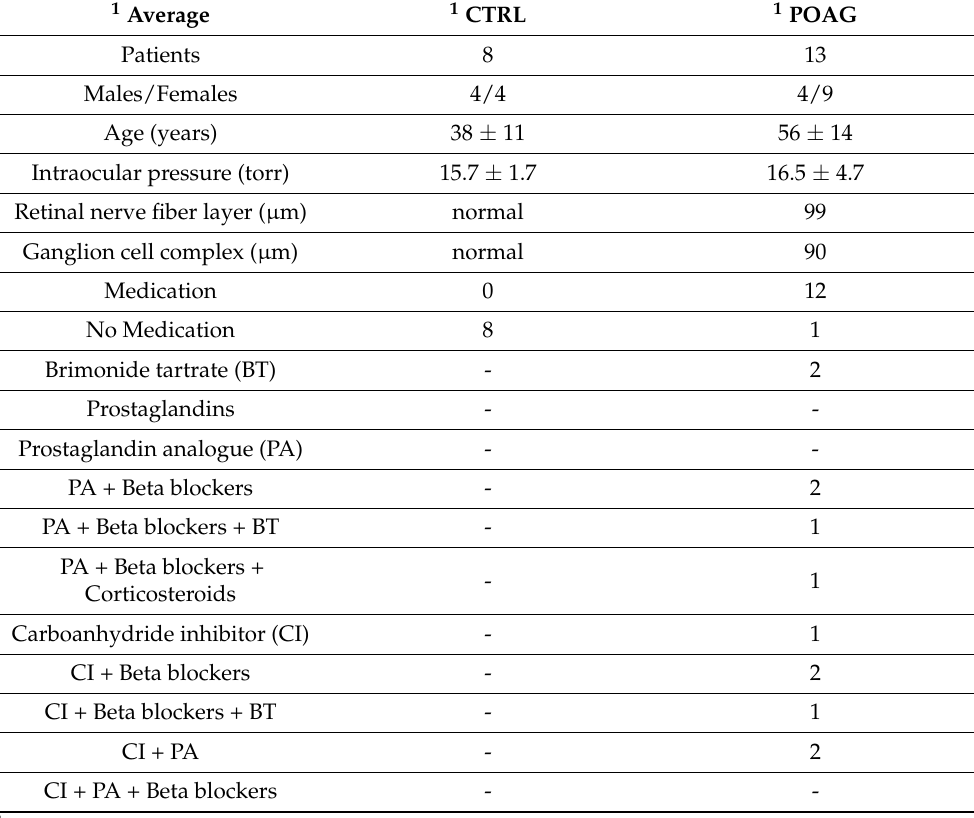
Table 1. Description of studied healthy subjects (CTRL) and patients with glaucoma POAG. 1 Average 1 CTRL 1 POAG Patients